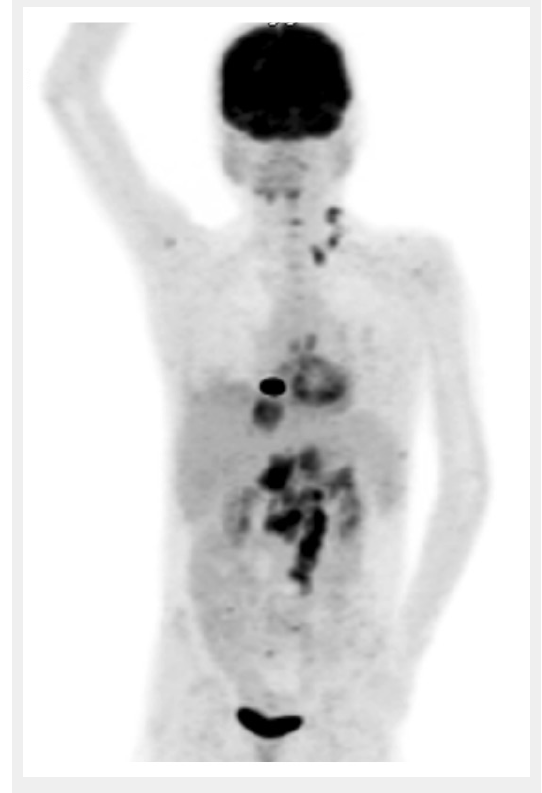
Figure 1 Positron emission tomography-computed tomography scan showing fluorodeoxyglucose uptake in the liver, bones and lymph nodes (highlighted Virchow’s node in the left supraclavicular